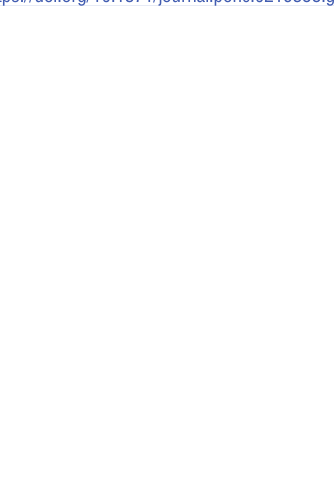
Fig 2. The effects of significant factors on incidence of stroke. The indicator and solid line present the z-value and 95% coefficient interval of ω , respectively; the lag with a bracket represents the integrated effect for two different lags with an increasing trend.